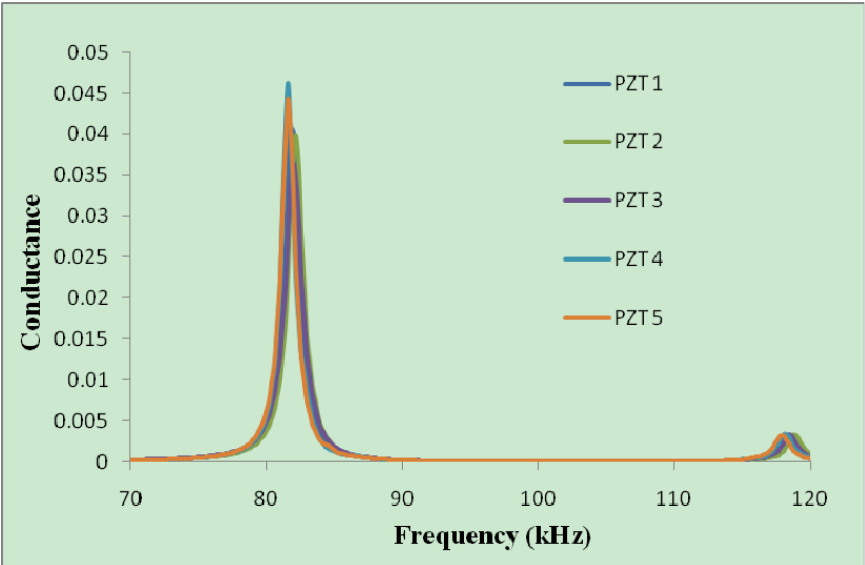
Figure 6. Free signatures obtained from PZT transducers.